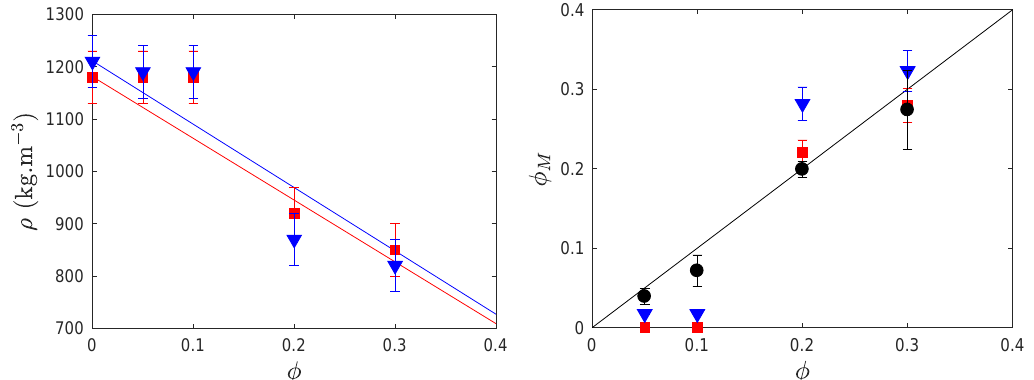
Figure 5. Left: Calculated densities of porous samples dried under ambient conditions (red symbols) or in an oven (blue symbols) as a function of the initial volume fraction of CaCO 3 . The lines are calculated using only the density ρ 0 of the bulk polymer: ρ = ρ 0 ( 1 − φ ) . Right: Porosity Φ M as a function of initial volume fraction φ of CaCO 3 obtained from image analysis (Section 3.2.2.2, black symbols) or density measurements (Section 3.2.2.1, blue and red symbols for oven or air-dried samples); the black line represents the expected porosity assuming an isotropic drying.